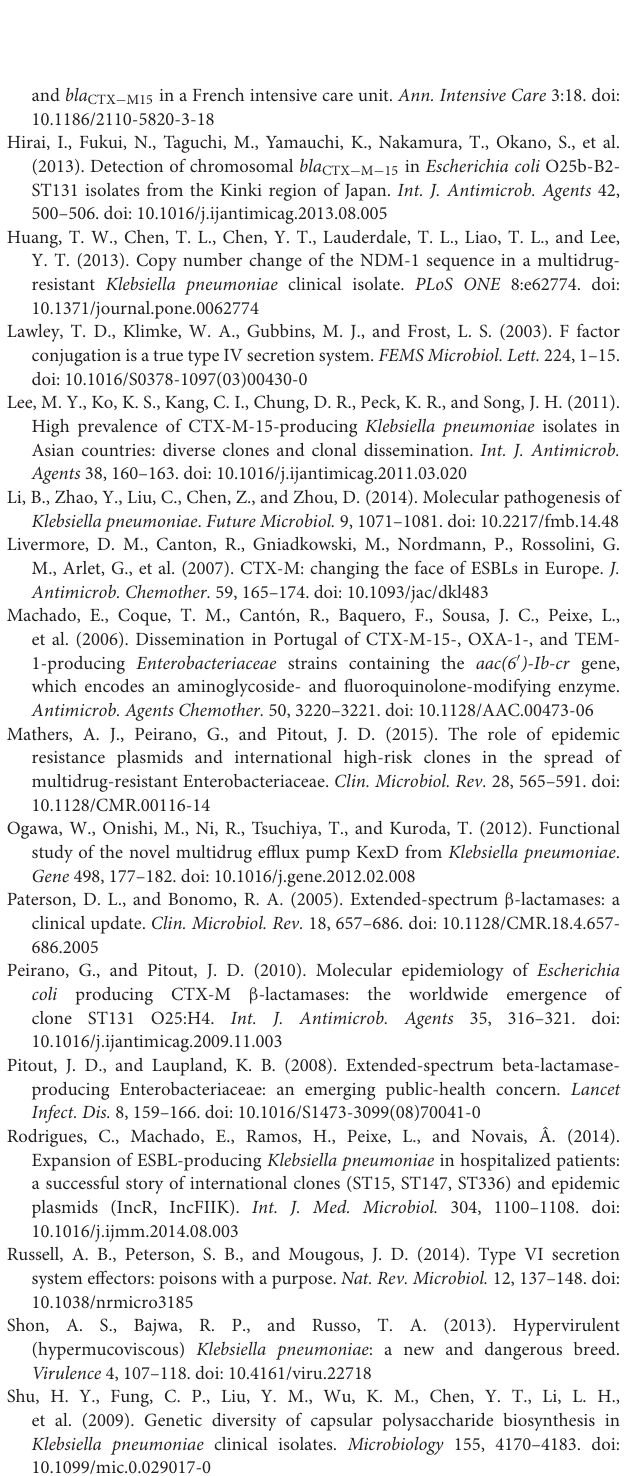
clpV gene of NTUH-K2044-Locus II and KPOI-Locus II is not shown in the figure since it is present on a different locus. Figure S3 | The tra region of the T6SS loci identified in the outbreak clone. The upper cases represent Tra proteins (e.g., A, TraA; B, TraB), and the lower cases represent Trb proteins (e.g., c, TrbC; f,